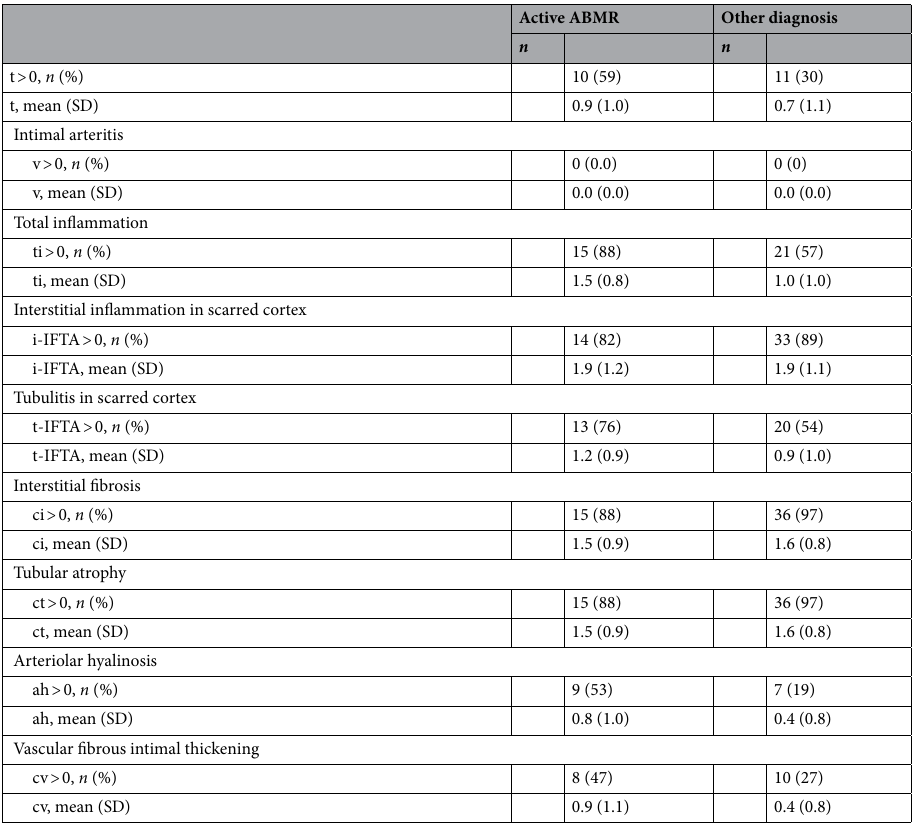
Table 1. Main clinical, biological and histological characteristics of the cohort. ABMR Antibody-mediated rejection, IQR Interquartile range, ESRD End-stage renal disease, HLA Human leukocyte antigens, DSA